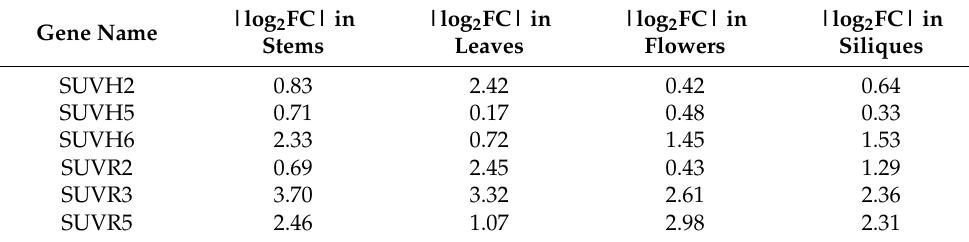
Table 1. The |log 2 FC| of SUV genes in four